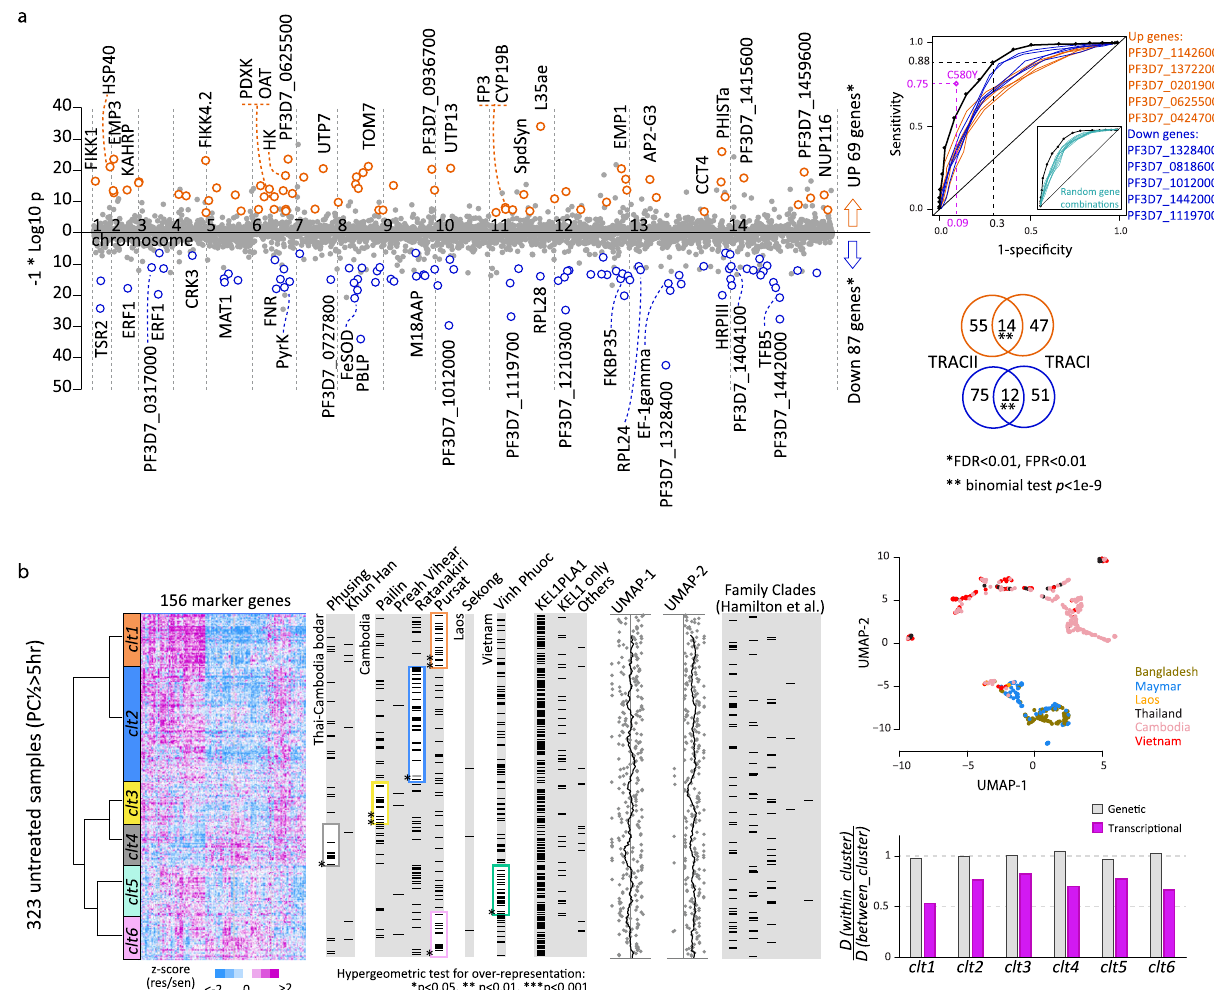
Fig. 2 Transcriptional resistance markers. a The scatter plot represents all studied genes along the genomic coordinates on the X -axis with their resistance-association p -values displayed as -log10 p on the Y-axis. Genes passing the threshold (FDR < 0.05, FPR < 0.05) are highlighted in 69 orange circles (upregulation) and 87 blue circles (downregulation). The ROC plot shows the ability to distinguish resistant and susceptible parasites in TRACII for 5 upregulated genes (orange) and 5 downregulated genes (blue) with the best performance. Their gene IDs are shown on the side from top to bottom for the line from left corner to the centre of the plot. The black line with dots represents the distinguishing ability of the combination of all the 156 genes which was calculated as the sum up of expression values of the 69 upregulations with a subtraction of the sum up of the 87 downregulations. It is compared to the roc of randomly selected gene set on the bottom right (see “ Methods ” ). The Venn diagrams show the overlap of TPAS results between the TRACII and TRACI studies. b A heatmap represents the transcriptional pro fi les clustering for 323 eGMS (bl) 0 h samples showing prolonged PC½( > 5 h) based on the 156 resistance markers. The colour (purple to blue) indicates the level of differential expression (upregulation to downregulation) in the resistant parasites. The left dendrogram represents Ward ’ s clustering result and the colour bars represent the 6 clusters obtained by clustering tree cutting. On the right, samples in each column (marked by black bars) are categorized by their respective sites or lineages, or population structure. Frames mark the overrepresentations of categorized samples in the corresponding clusters. * p < 0.05, ** p < 0.01 and *** p < 0.001. The scatter plot represents the population structure of the whole GMS samples, and the bar plot represents the ratio of distance between within-clusters individuals and between-clusters individuals (see “ Methods ”